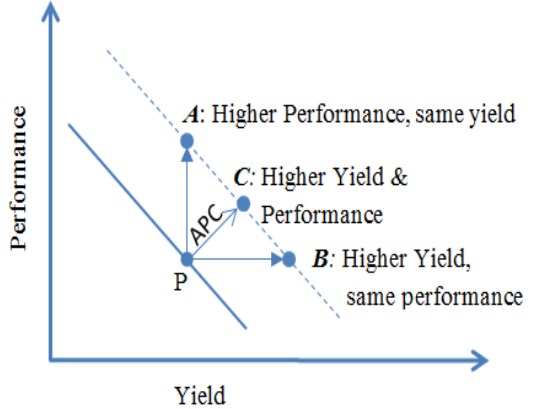
Figure 3. Shifting a simplified yield ‐ quality line with the use of advanced process control (APC). Modified from [51].